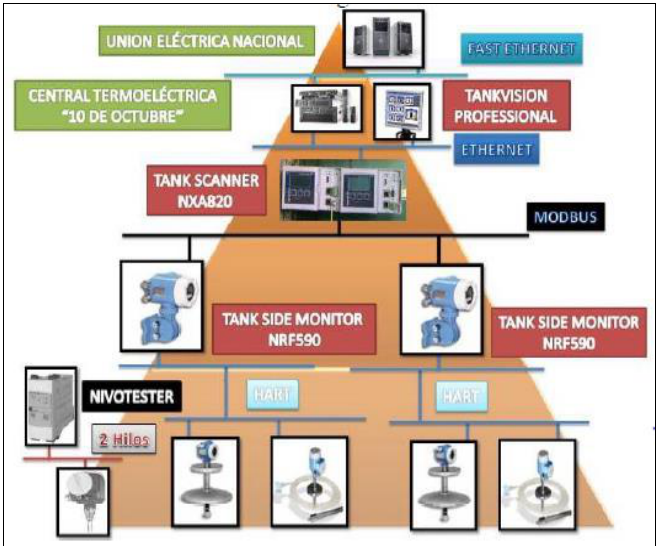
Figura 5: Pirámide de Automatización del sistema TankVision. Fuente: Los Autores, (2015).